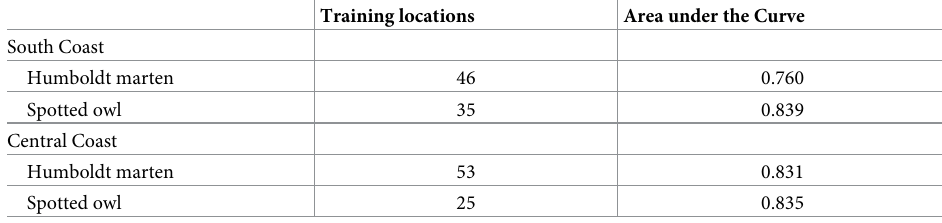
Table 2. Maxent modeling statistics for northern spotted owls ( Strix occidentalis caurina ) and coastal Pacific mar- ten ( Martes caurina humboldtensis ) in the Oregon coast range. The area considered was within 10km of known marten locations, using spotted owl data from demographic studies